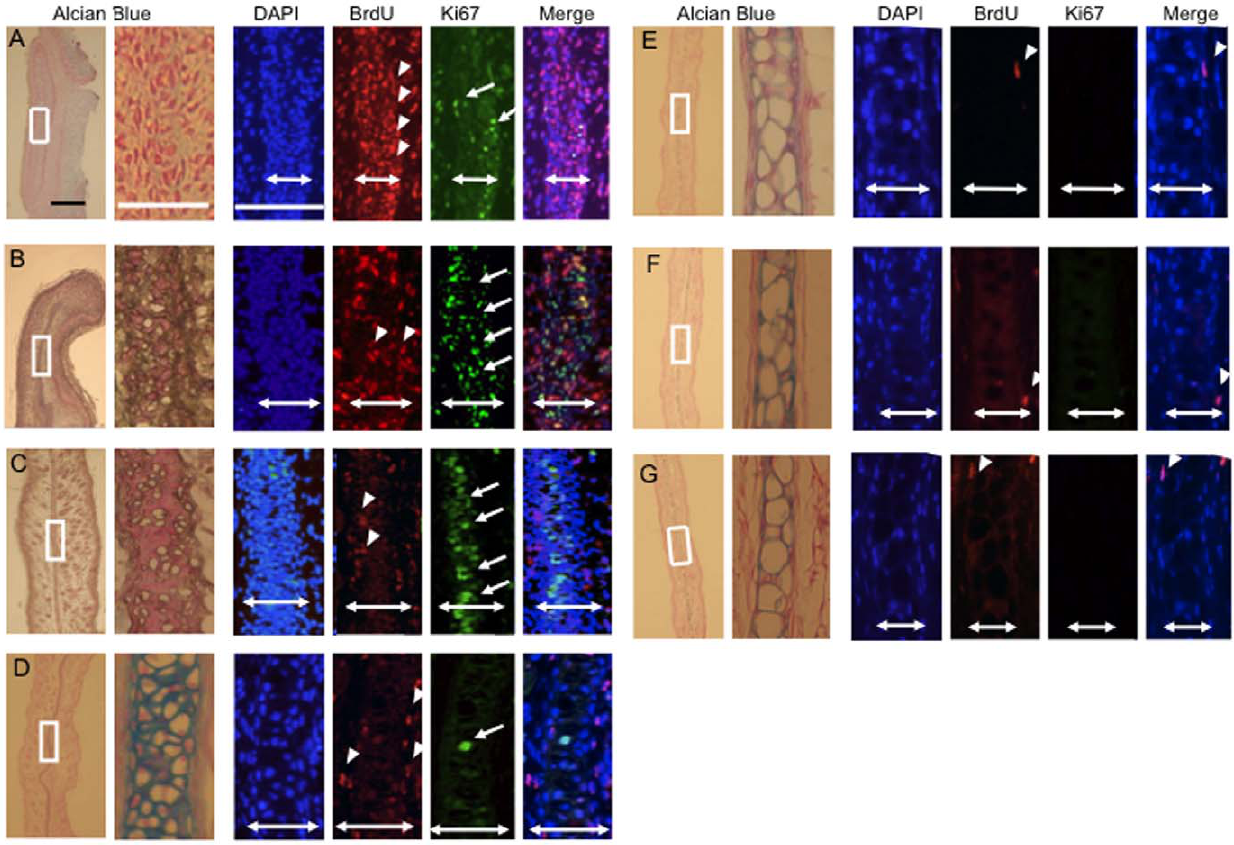
Figure 2. 48-week chase analysis of BrdU-labeled cells and Ki67-positive cells. BrdU-labeled cells gradually decreased in auricular cartilage (White arrowheads). A few BrdU-labeled cells were present in the perichondrium of 48-week-old, BrdU-labeled offspring. No LRCs were observed in chondrocytes of the chondrium 4 weeks after BrdU labeling. No Ki67-positive cells were seen in perichondrium 1 week following birth (White arrows). No Ki67-positive cells were observed in the chondrium 2 weeks following birth. (A) 0 day, (B) 3 day, (C) 1 week, (D) 2 weeks, (E) 4 weeks, (F) 24 weeks and (G) 48 weeks. From the left, Alcian blue staining, DAPI, BrdU, Ki67, and a merged image. Two-headed arrows: the cartilage width including perichondrium. Black scale bar=200 m m, White scale bar=50 m